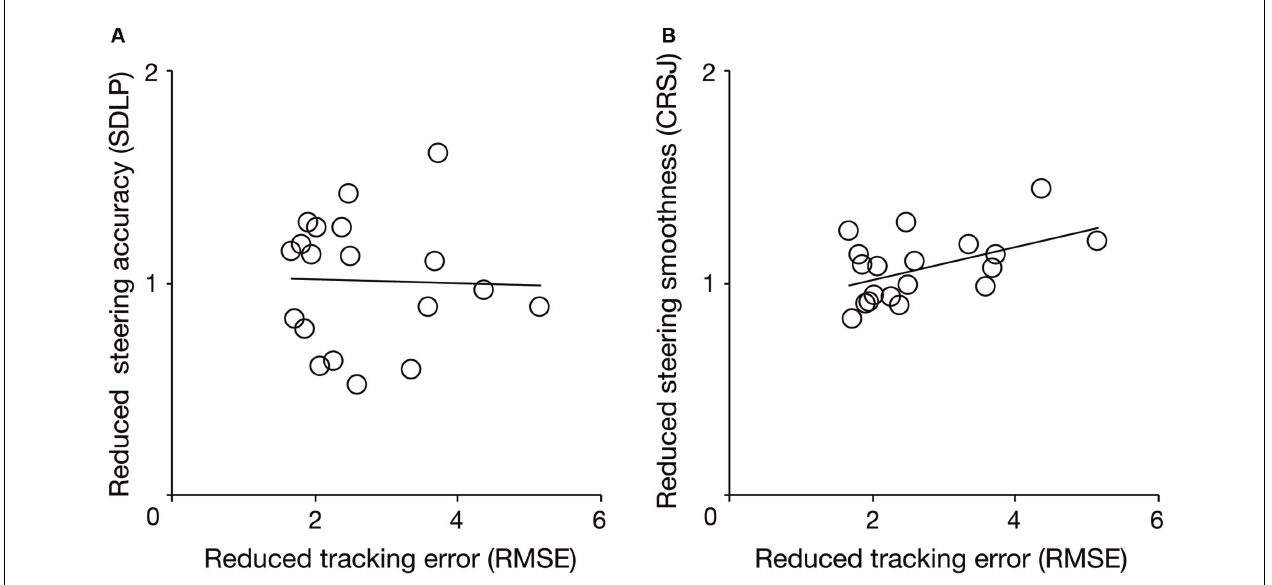
FIGURE 6 | Correlation of the reduced tracking performance with the reduced driving performance [steering accuracy: (A) , steering smoothness: (B) ]. The reduced tracking performance was calculated by normalizing the values of the indices in the invisible cursor condition (IC) by those in the visible cursor condition (VC), and the reduced driving performance was calculated by normalizing the values of the indices in the clockwise circling condition (CW) by those in the counter-clockwise circling condition (CC). RMSE, SDLP, and CRSJ denote the root mean square of the position error, the standard deviation of lateral position, and the cumulative root squared jerk,